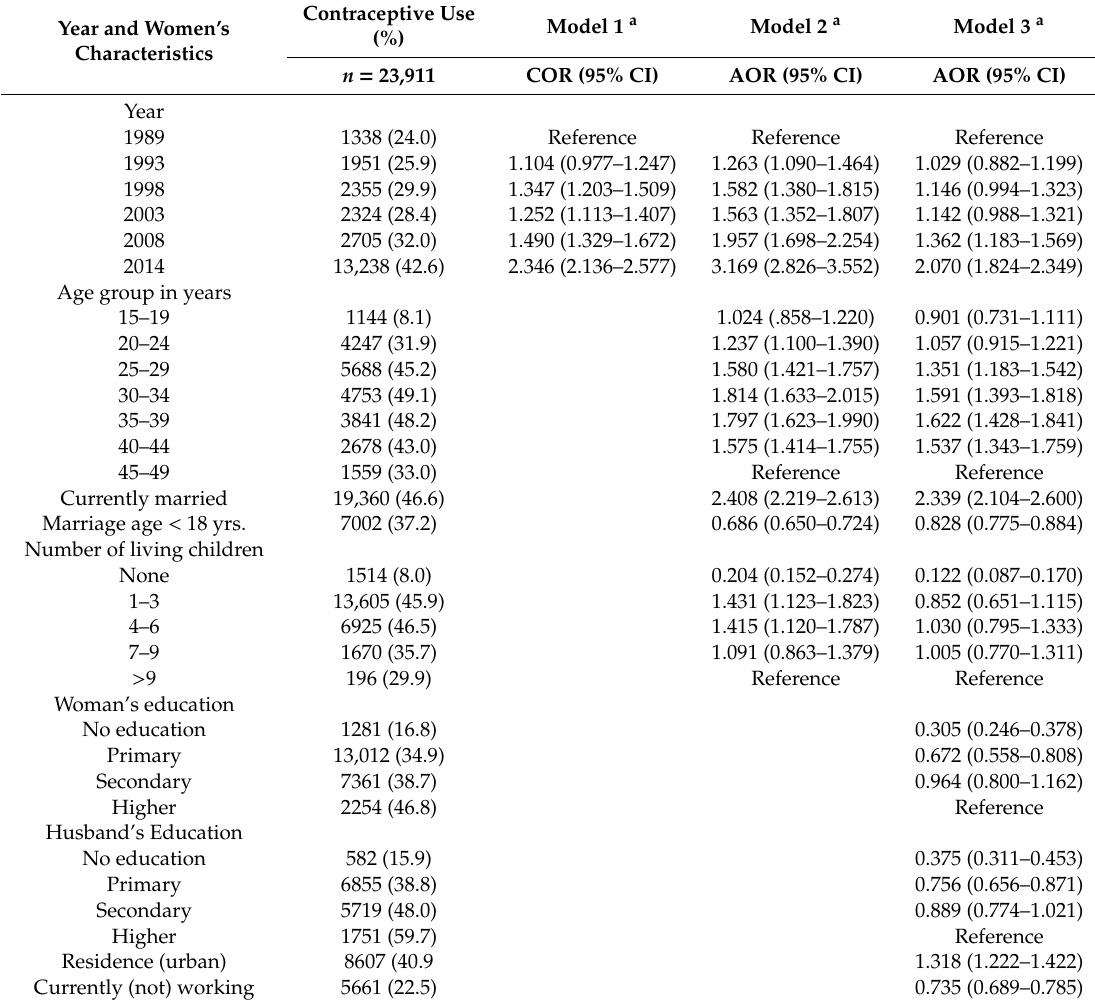
Table 2. Odds ratios and 95% confidence interval of contraceptive use in relation to calendar year as well as social and demographic factors in Kenya from 1989 to